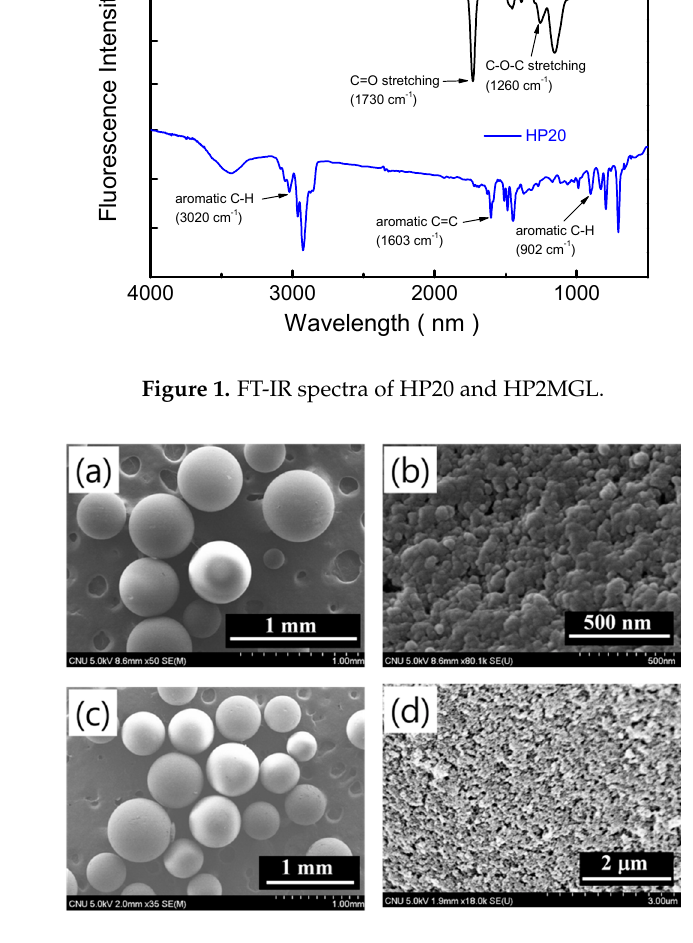
Figure 2. SEM images of ( a , b ) HP20 and ( c , d ) HP2MGL. Table 1. Surface Properties of HP20 and HP2MGL.